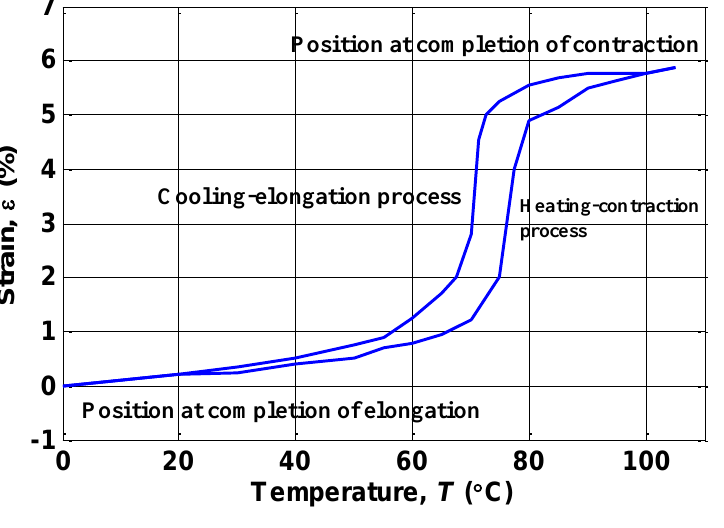
Figure 5. Relationship between strain and temperature for BMF150